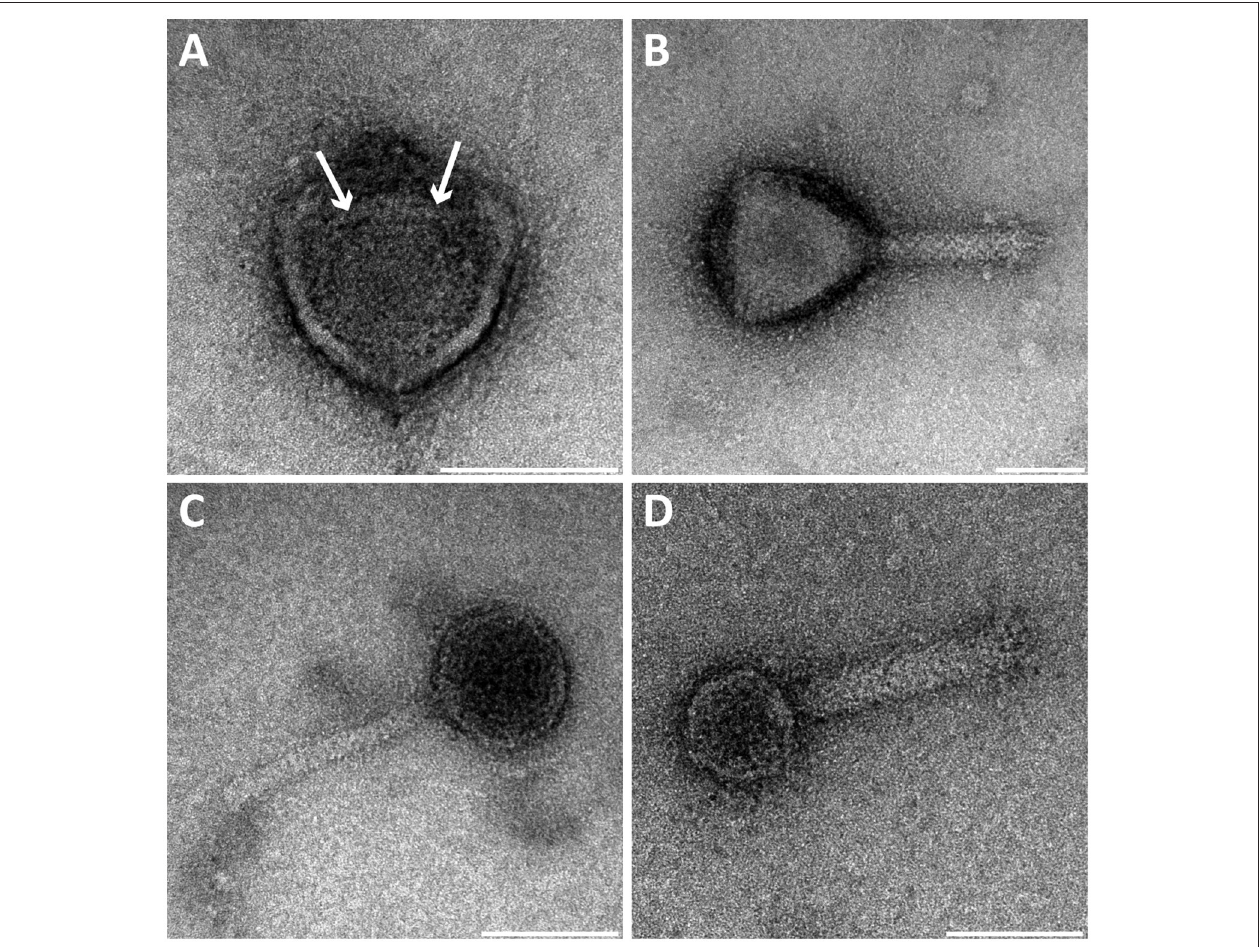
FIGURE 1 | Transmission electron micrographs of negative-stained bacteriophages present in the Methylomirabilis bioreactor enrichment culture. Four viral morphotypes were observed. (A) Viral morphotype with putative icosahedral symmetry of the head ( ∼ 71 nm diameter), without a tail or other appendages but with a central round internal core ( ∼ 25 nm diameter, see arrows). (B–D) Three additional viral morphotypes all with a tail and a putative icosahedral symmetry of the head ( ∼ 87, ∼ 50, and ∼ 41 nm diameter respectively). Scale bars; 50